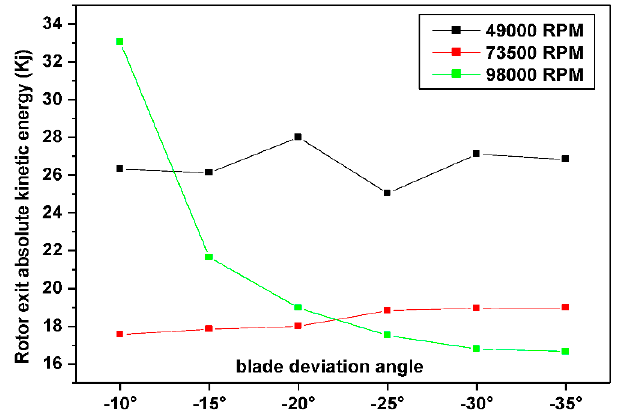
Figure 18. Rotor exit total kinetic energy for different deviation blade angles.